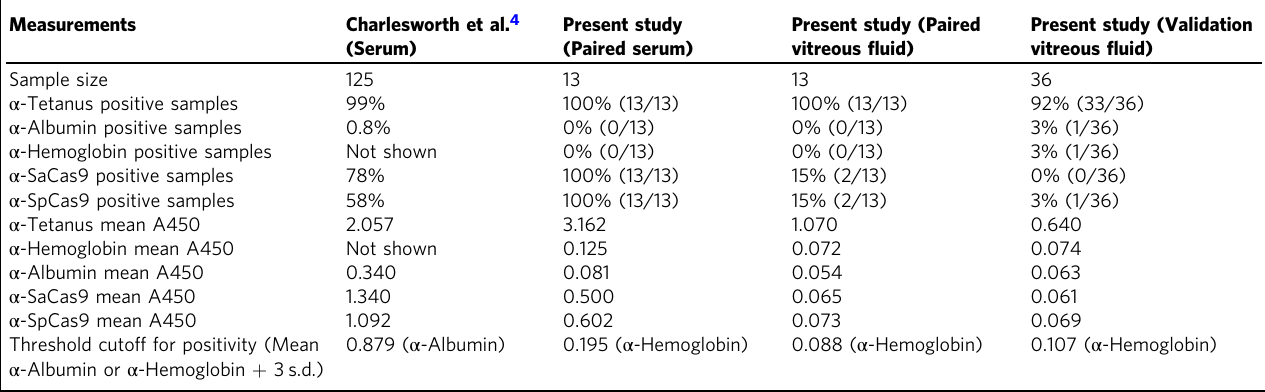
Table 1 Comparison of mean ELISA A450 signals in serum and vitreous fl uid. Measurements Charlesworth et al.